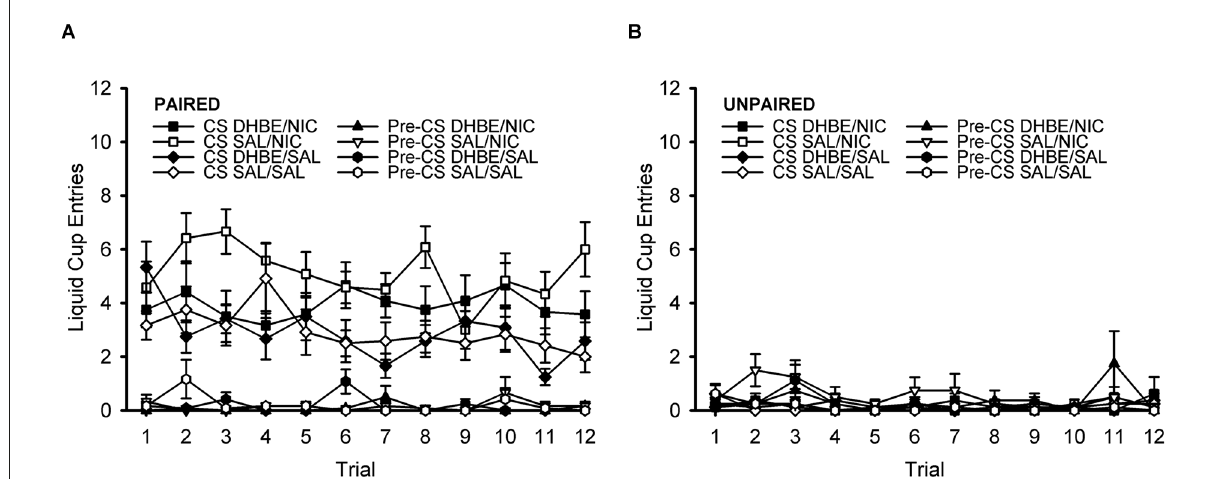
FIGURE6 Pavlovian conditioned response to an alcohol cue during the DH β E test session shown on a trial-by-trial basis. The attenuation of the nicotine- induced enhancement in the Pavlovian conditioned response to an alcohol cue by the β 2* nAChR antagonist dihydro-beta-erythroidine (DH β E) did not change significantly across the course of the test session. Data represent the mean ( ± SEM) number of liquid cup entries during the first 9 s of the CS and during a 9-s pre-CS interval for the paired group (A) and the unpaired group (B) . Black symbols represent DH β E treatment and white symbols represent saline treatment. In the legend, the abbreviation before the slash identifies the antagonist treatment (DH β E or saline) and the abbreviation after the slash identifies the drug group (nicotine or